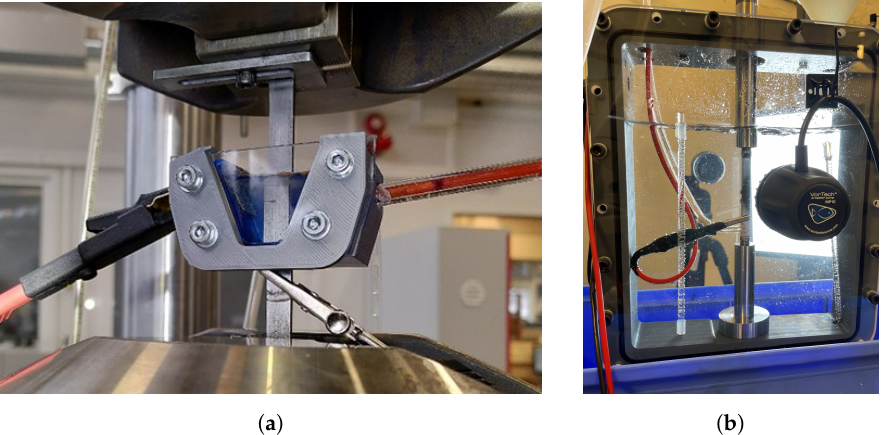
Figure 2. Electrochemical hydrogen charging chambers used for SSRT and cyclic testing. ( a ) SSRT specimen installed in the 3D-printed charging chamber [25]. ( b ) Chamber used for cyclic